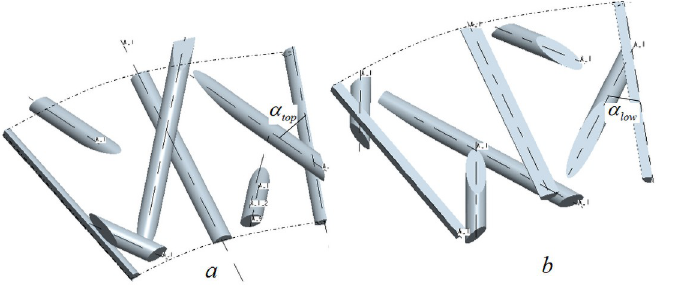
Fig 12. Positional relationship between upper and lower surface